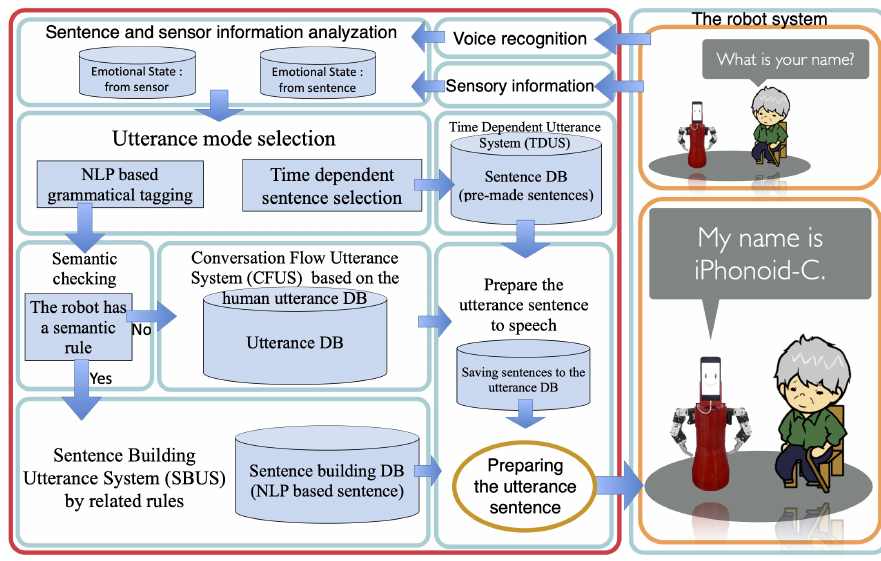
Figure 10. Structure of the conversation